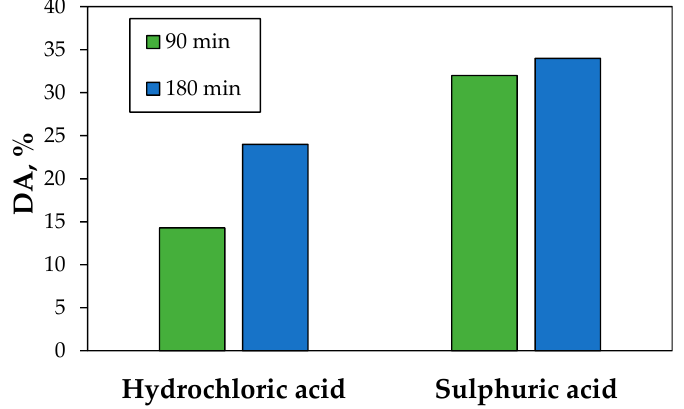
Figure 9. Desorption/adsorption effectivity of copper by two desorbing agents, HCl and H 2 SO 4 , for two different desorption periods, 90 and 180 min.